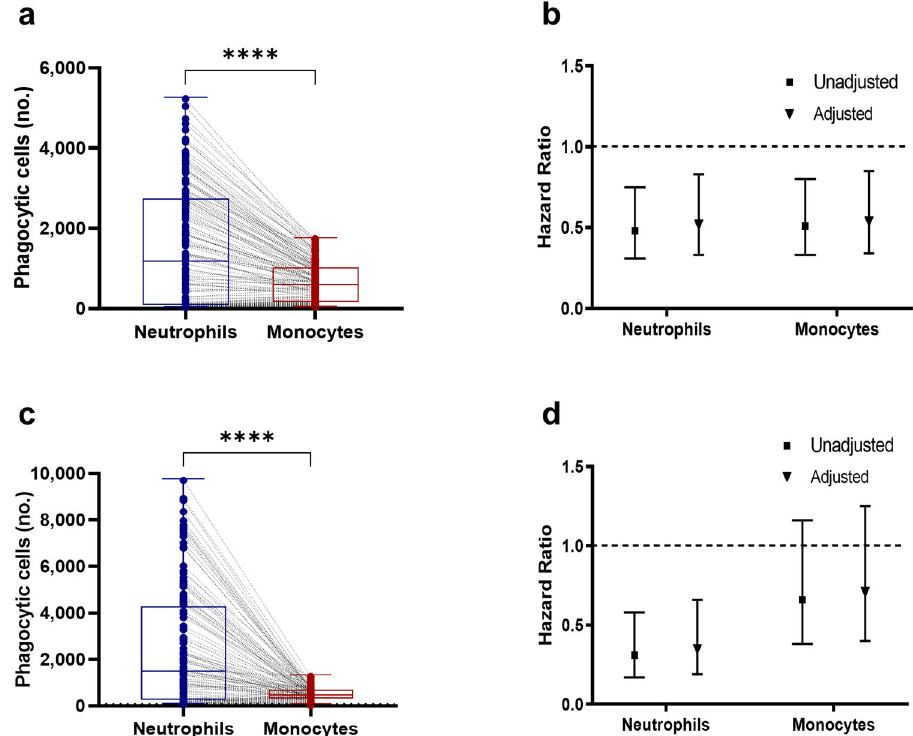
Fig. 4 Neutrophil-phagocytosis of merozoites is dominant compared to monocytes and predicts protection against febrile malaria. Paired aligned dot plots coupled to box and whiskers plots showing the number of EtBr-positive neutrophils and monocytes present in PBLs from Danish blood donors which were used as effector cells to test the phagocytosis mediating ability of antibodies present in Ghanaian a and Indian c cohort plasma samples. Both the Ghanaian children ( n = 140; protected = 59, susceptible = 81) b and the Indian participants ( n = 121; protected = 71, susceptible = 50) d were categorized into two equal groups based on the median phagocytosis values obtained with neutrophils or monocytes, and the risk of encountering febrile malaria during the follow-up periods was calculated with Cox-regression models comparing those with high versus low (reference group) phagocytosis. Values represent age-adjusted ( fi lled triangles) and unadjusted ( fi lled squares) hazard ratios with 95% con fi dence intervals. Boxes indicate the median and interquartile range. Whiskers mark the minimum and maximum values. P values were determined by Wilcoxon signed-rank test a and c . Asterisks represent P values (**** P <